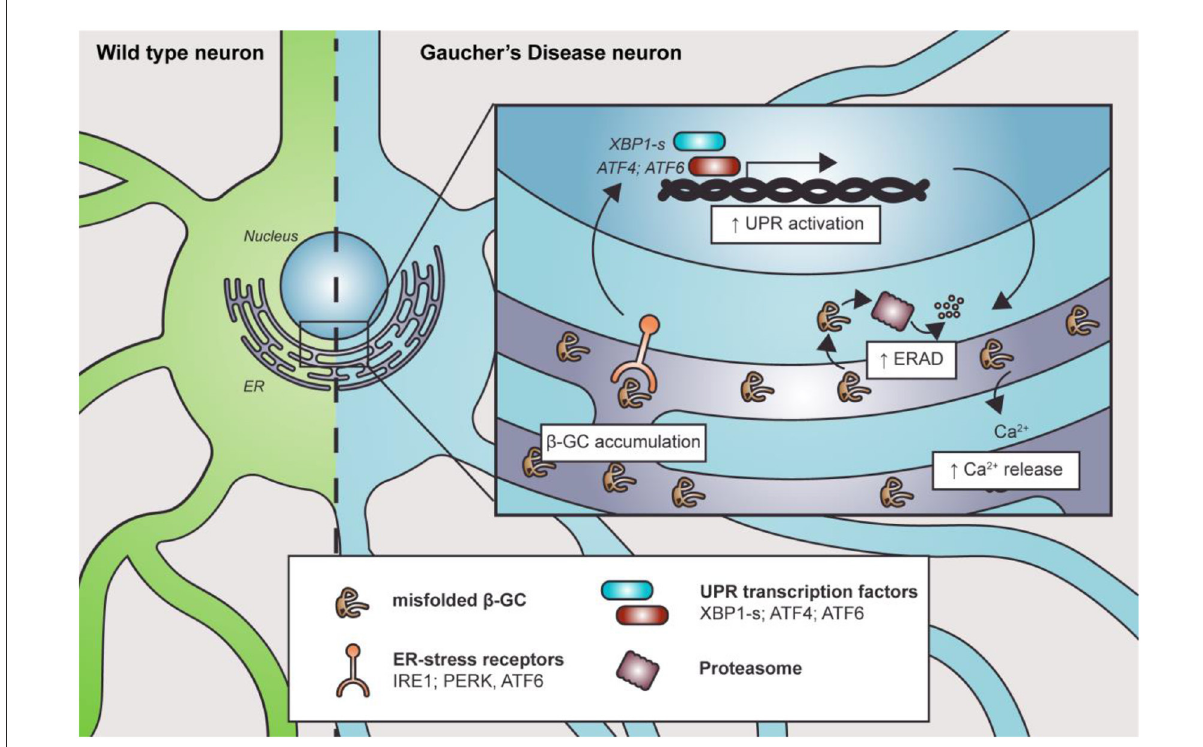
FIGURE2 Misfolded β -GC mediates ER stress. Mutations in GBA1 lead to β -GC misfolding, promoting the activation of ER stress receptors and the UPR. This, in turn, induces degradation of the misfolded enzyme through ERAD. Along with this, Ca 2 + homeostasis is also altered, contributing to cell and organelle